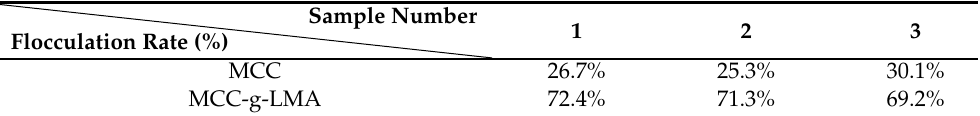
Table 4. Experimental results of flocculation performance of MCC and MCC-g-LMA.